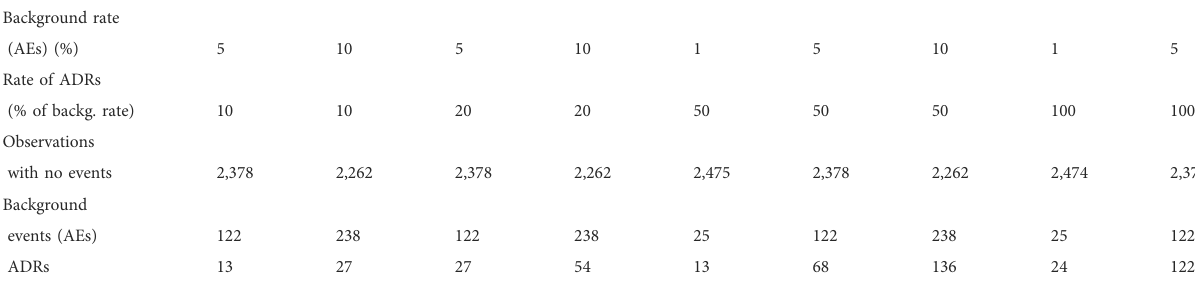
TABLE 1 Average sample sizes for an simulated population of 2,500. ADR: adverse drugs reaction. Background